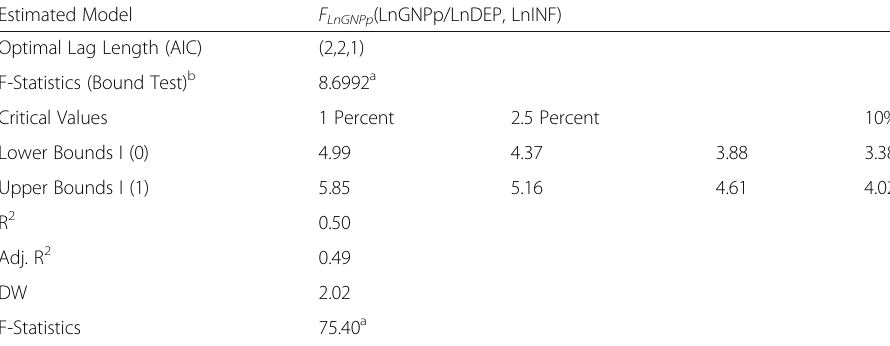
Table 4 Results of the Bounds test of Cointegration Estimated